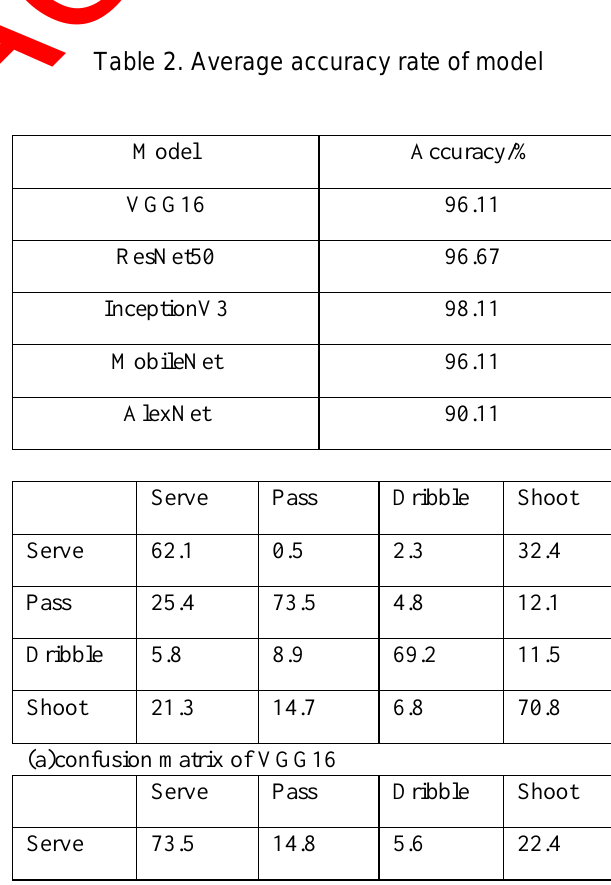
Table 2. Average accuracy rate of